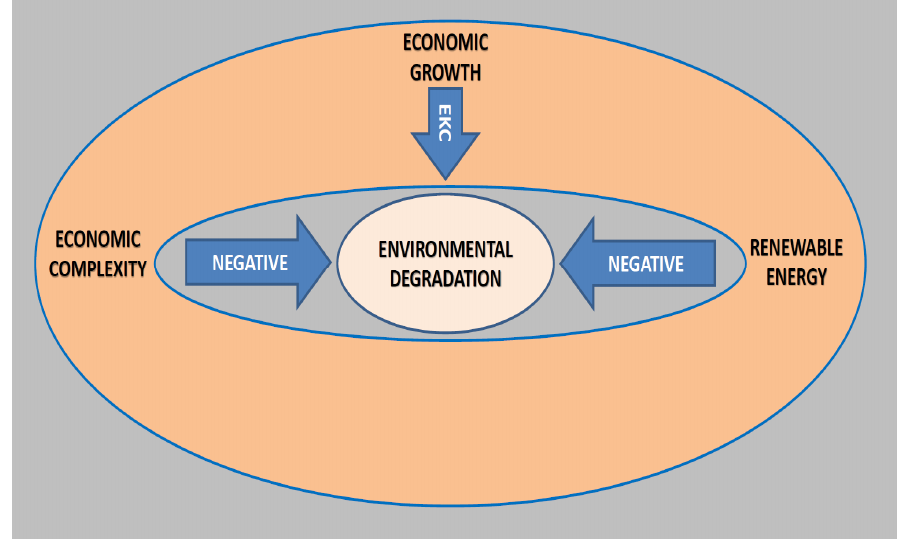
Figure 5. Graphical scheme. Source: Authors’ elaboration.